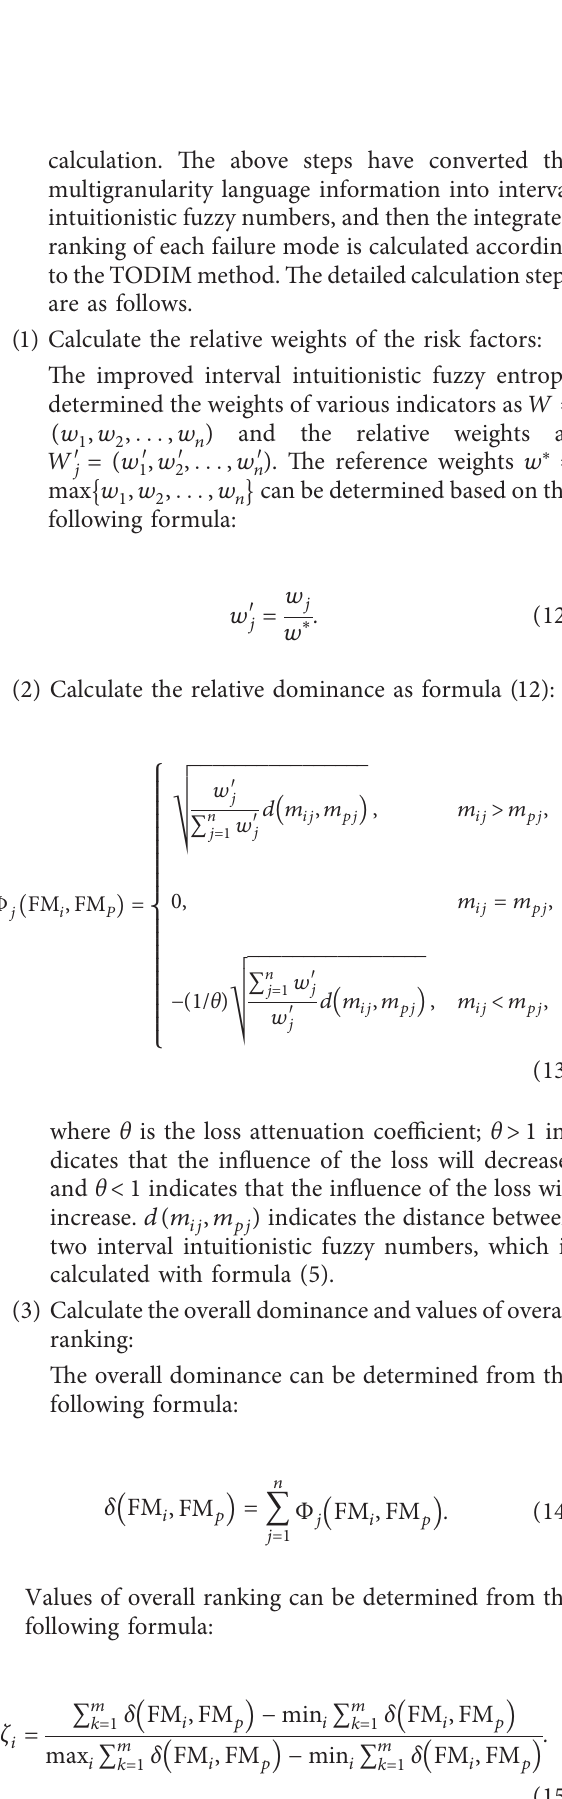
Scoring rules: scoring from the three different granular language variables, i.e., 5, 7, and 9, is listed as